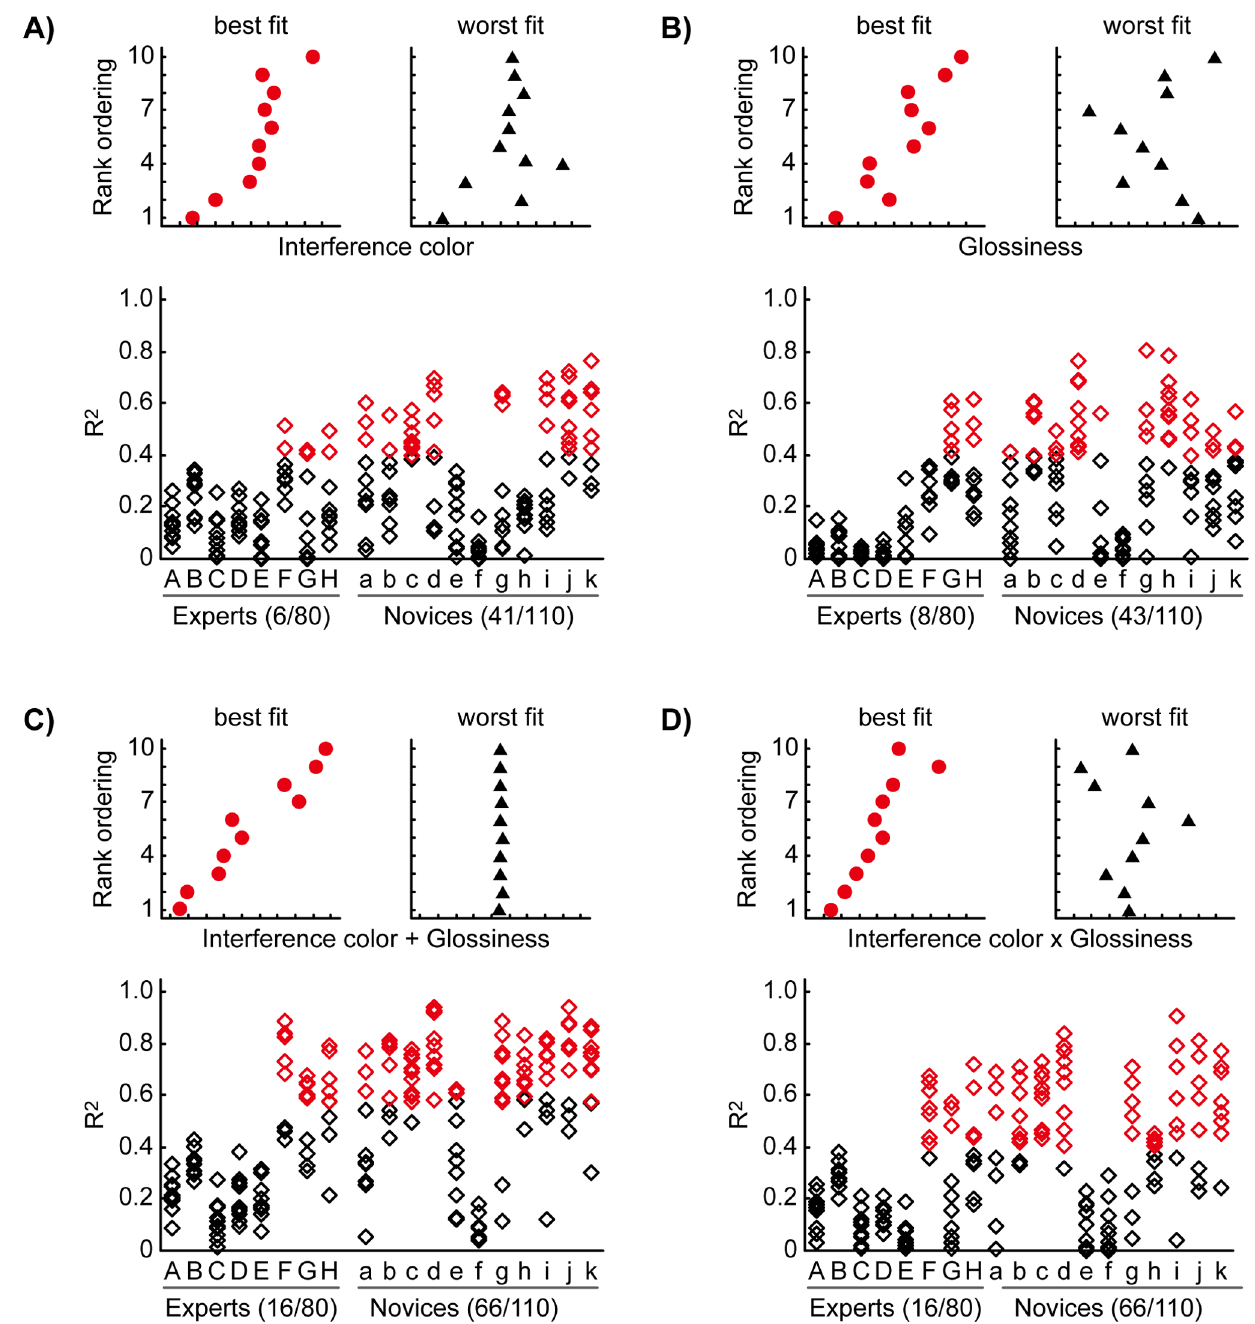
Figure 5. Regression analyses by measured variables. In all panels, the upper insets show the best (left) and worst (right) regression results. The vertical axes show the rank orderings, and the horizontal axes show either the explanatory variable (in A, B, D) or the prediction from the regression equation (in C). The lower graphs show the results of all the regressions. In all graphs, each point represents one trial, and each row represents one participant. The numbers written in parentheses are the numbers of trials for which the regression is significant (shown by red points) and the total number of trials. The vertical axes show the coefficients of determination (R 2 ). (A and B) Results of simple linear regression analyses on interference color and glossiness, respectively. (C) Results of multiple regression analyses on both variables separately. (D) Results of simple linear regression analyses on the product of both variables.